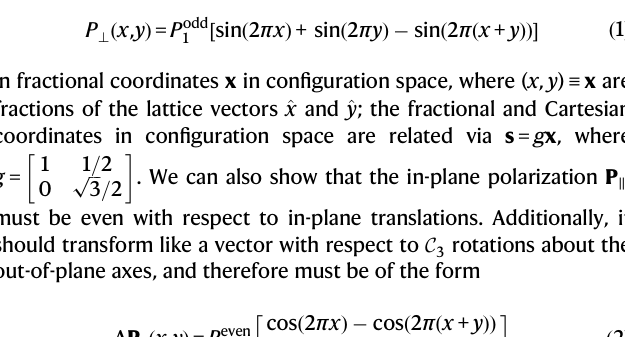
are fi tting to C 3 symmetric basis functions. The winding of the total polarization alongthecon fi gurationspacediagonalissketchedabove.2Dplotof c out-of-plane and d in-plane polarization Δ P ∥ in con fi guration space, in Cartesian coordinates s =( s x , s y ) and ∣ a ∣ is the bilayer lattice constant. The black arrows represent the commensurate bilayer lattice